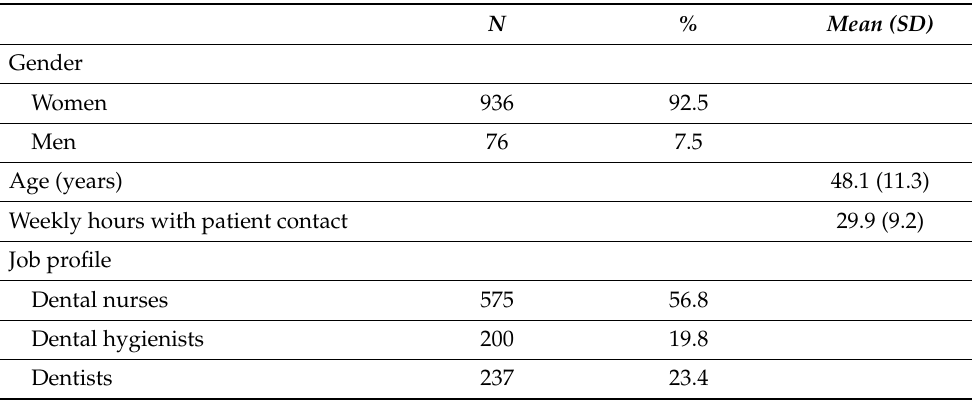
Table 1. Participant demographics ( n =